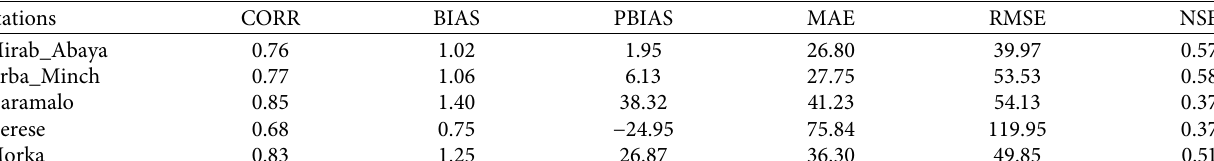
Table 6: Monthly comparison of five rain gauges and the CHIRPS satellite at a point scale from 2000 to 2020.